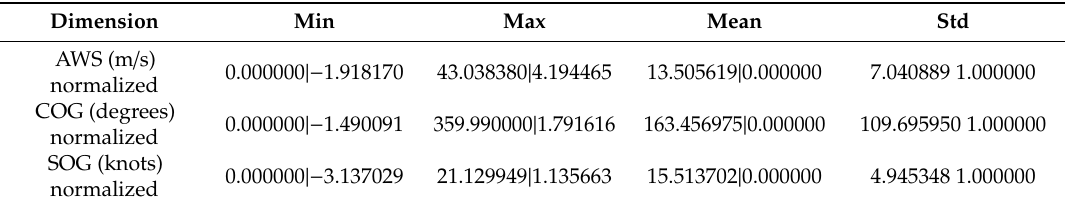
Table 3. Exemplary three dimensions data normalization.